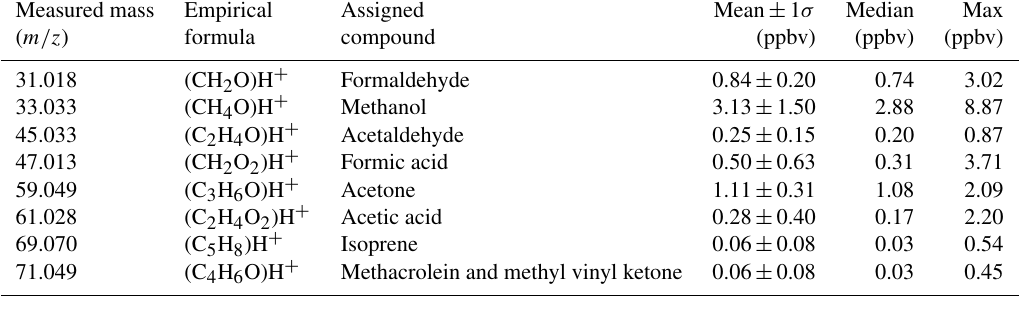
Table 1. Abundance (ppbv) of major volatile organic compounds (VOCs) measured at Toolik Field Station (TFS) in early summer 2019. Data have been filtered for stagnant air and local pollution influences from the field station (see text). An extended table containing the full mass spectrum of all identified PTR-ToF masses is provided in Table S1.